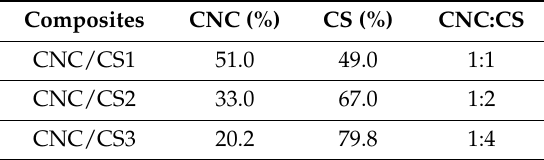
Table 2. Cellulose nanocrystal and chitosan weight percentage in the composites.